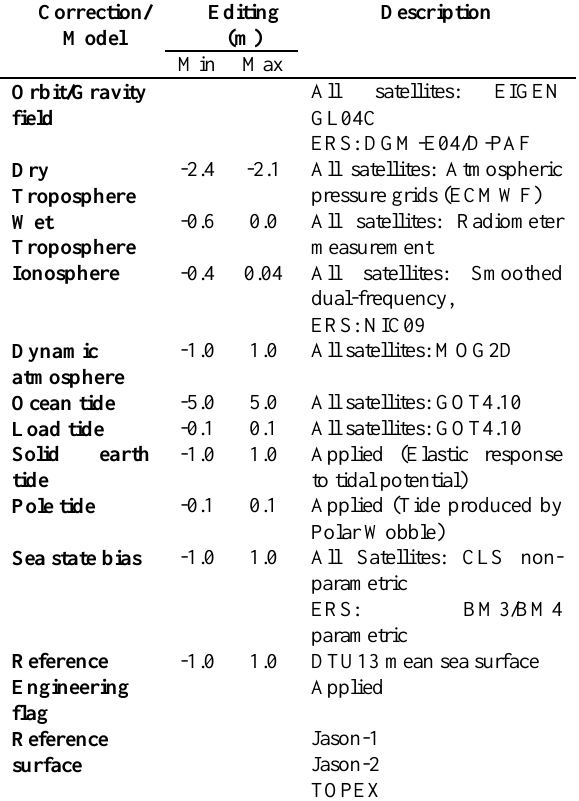
Table 1. Corrections and models applied for RADS altimeter